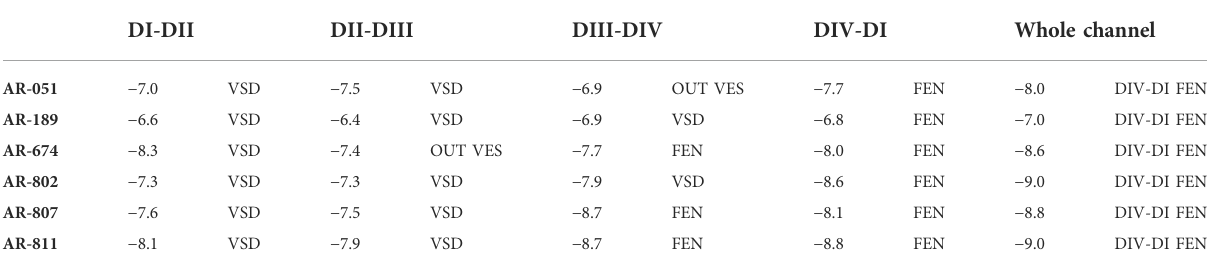
*VSD, Voltage-Sensing Domain. *OUT VES, outer vestibule. *INN VES, inner vestibule. *FEN,